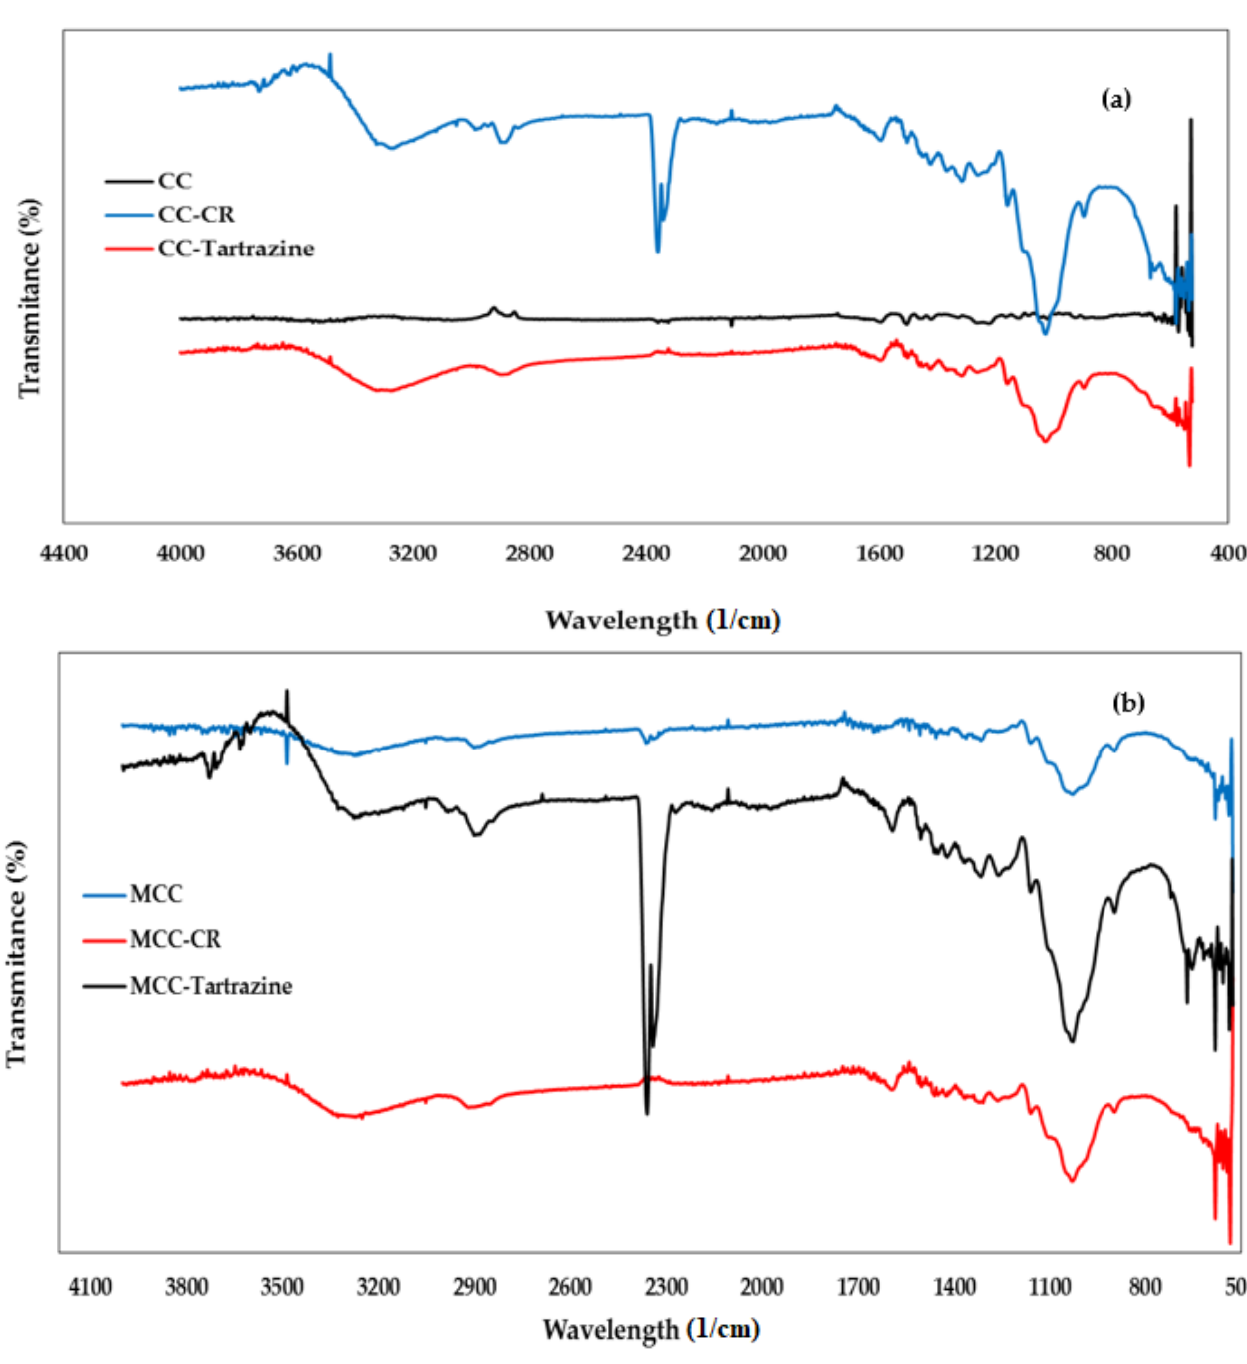
Figure 2. IR spectra of ( a ) CC and ( b ) MCC before and after removal of CR and tartrazine. Table 3. Peak position and chemical group assignments in the CC and MCC. Peak (Wavelength cm −1 ) Functional Group Chemical Component CC MCC